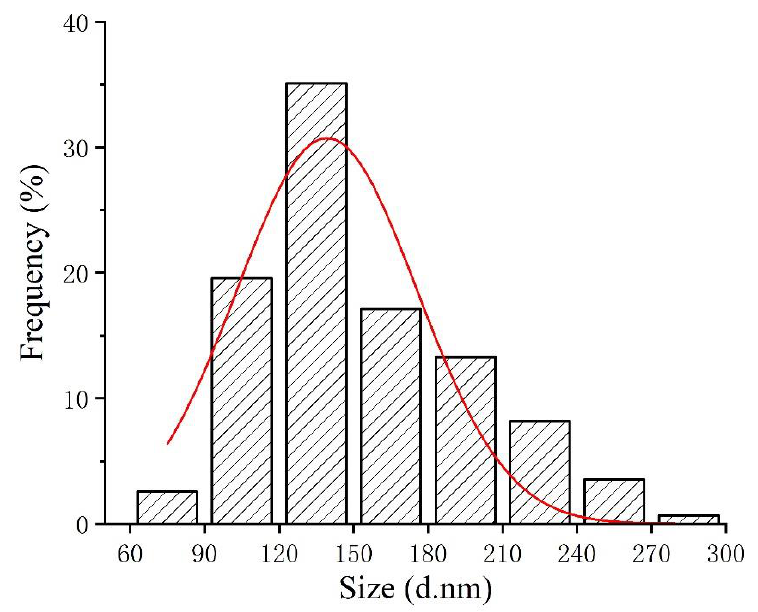
Figure 1. Particle size distribution map of